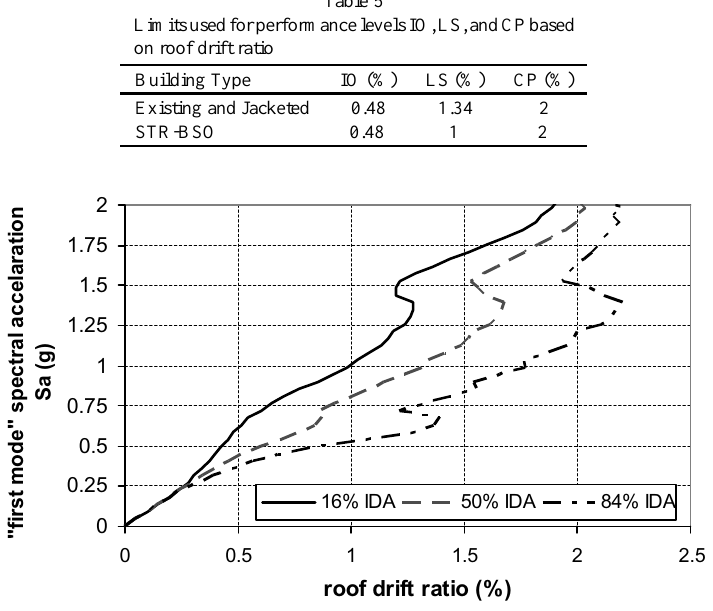
Fig. 5. Spectral acceleration vs. roof drift ratio curves for different IDA levels.